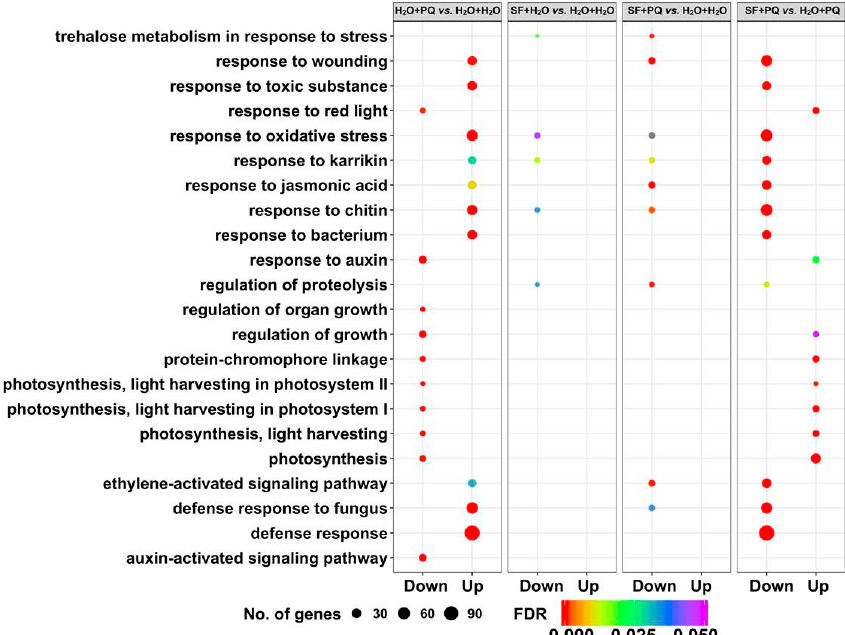
Figure2. ComparisonofthetopfiveenrichedGOcategoriesfromallpairwisecombinations. Thetopfive (most significant) enriched biological process GO terms from all pairwise combinations are illustrated as a bubble plot. The size and color of the circle denotes the number of di ff erentially expressed genes and FDR (false discovery rate) adjusted p -value, respectively. Unprimed and unstressed (H 2 O + H 2 O), PQ-stressed (H 2 O + PQ), SF-primed but unstressed (SF + H 2 O), and SF-primed and stressed (SF + PQ).